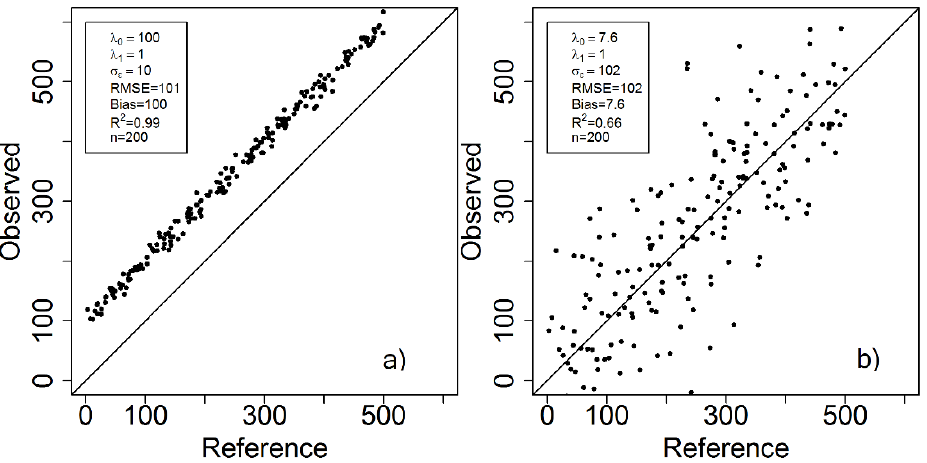
Figure 1. Example of two cases with different properties of the errors where the root mean square error (RMSE) is almost identical; in the left case ( a ) the systematic error component dominates whereas in the right case ( b ) the random error component dominates.